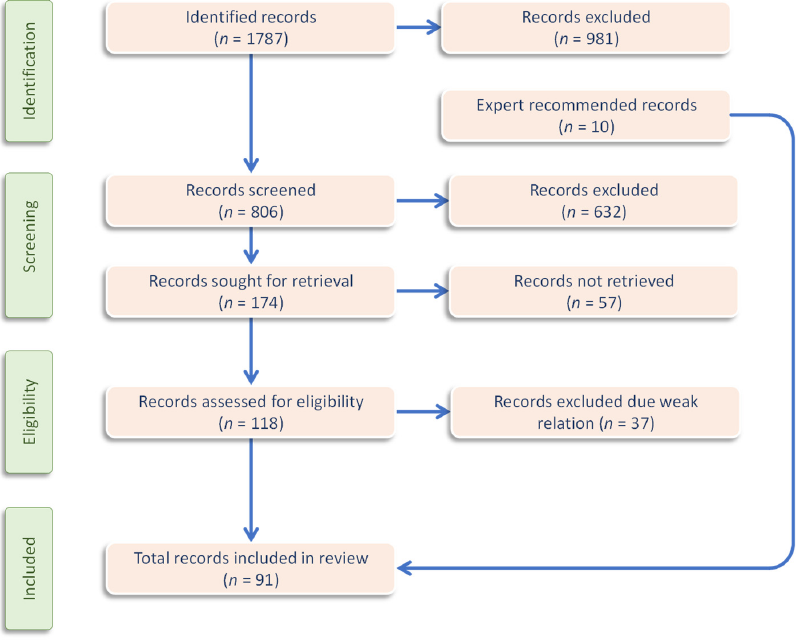
Figure 1. Preferred reporting items for systematic reviews and meta-analyses process.